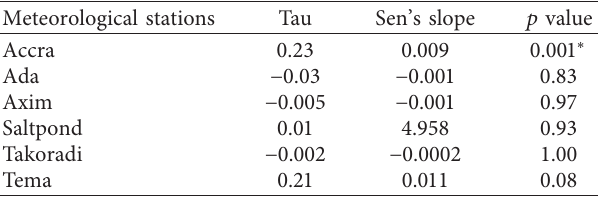
Figure 4: Time series analysis of JFM, NDJ, and DJF SPI for all six synoptic meteorological stations of Coastal Table 2: JFM SPI modified Mann–Kendall test.